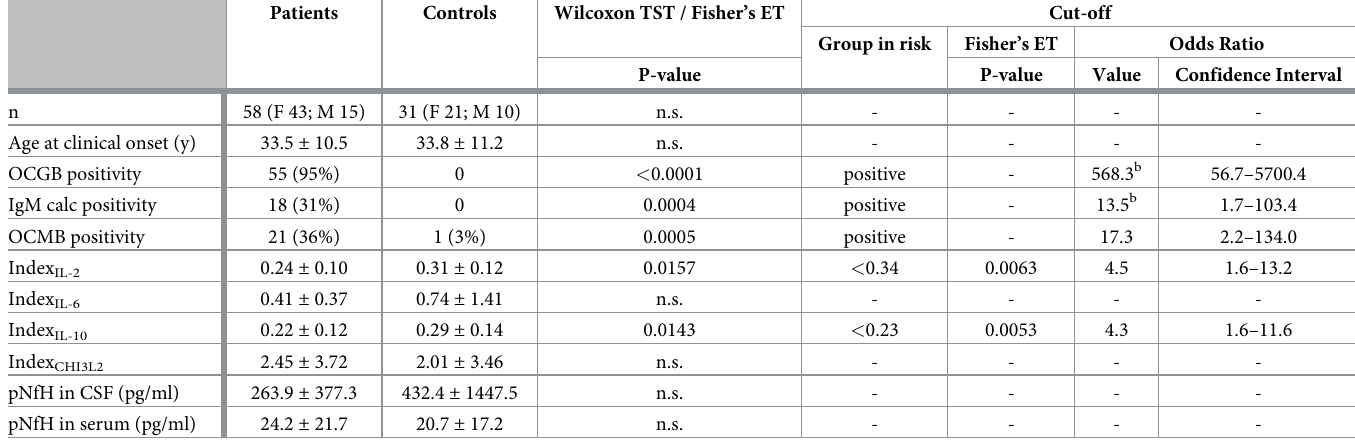
Table 1. Baseline characteristics a